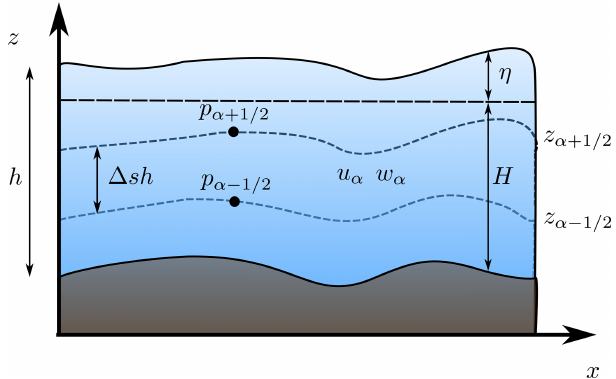
Figure 1. Schematic diagram describing the multilayer